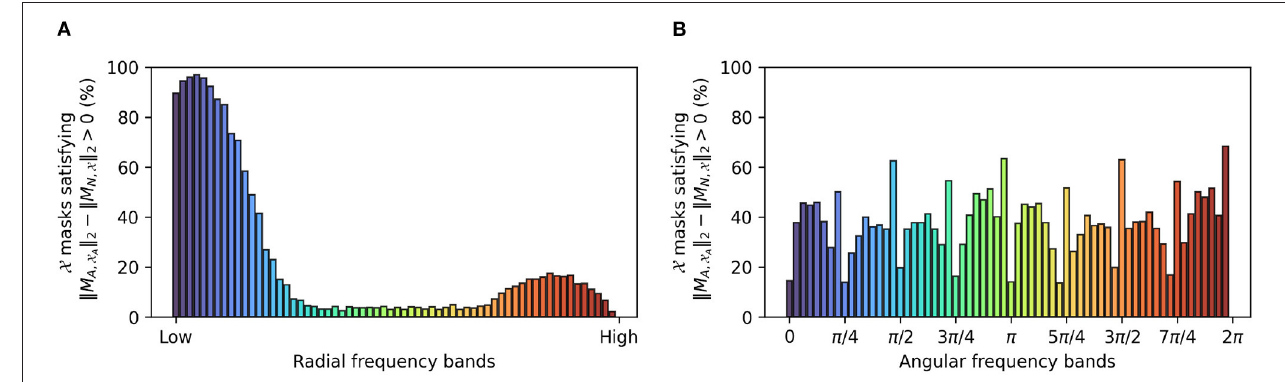
FIGURE 7 | Comparison of X -trained masks ( M N , X ) obtained for the vanilla network and X A -trained masks ( M A , X bars illustrate the percentage of masks for which the per-band energy [radial (A) and angular (B) ] in in M A , X